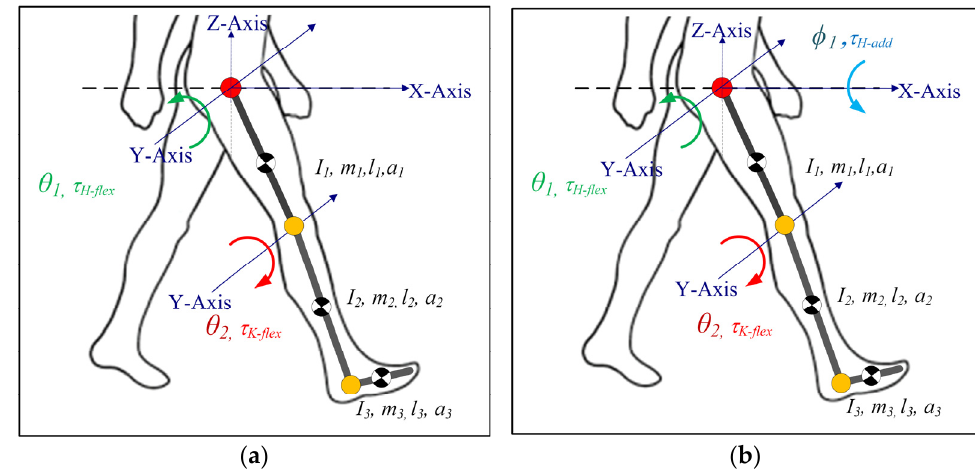
Figure 1. Lower limb model for C-LREX ( a ) 2DOF ( b ) 3DOF ( I , m , l , a represent the moment of inertia, mass, length of the link, and distance of CG of the link from the joint center. The subscripts 1 , 2 , and 3 refer to link 1 (thigh), link 2 (shank), and link 3 (foot)).